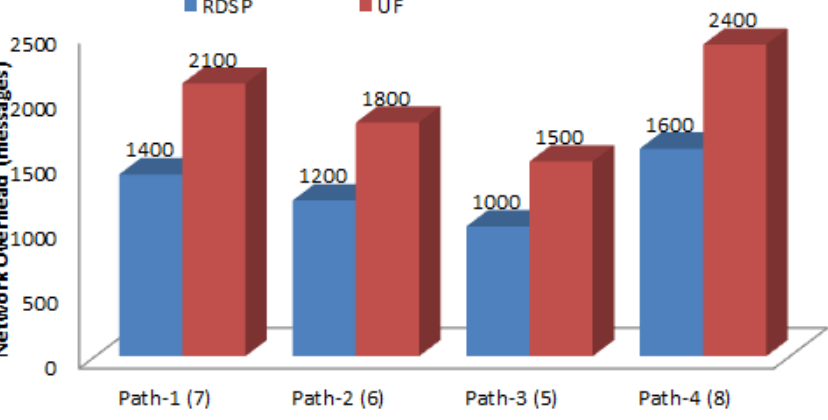
Figure 12. Network